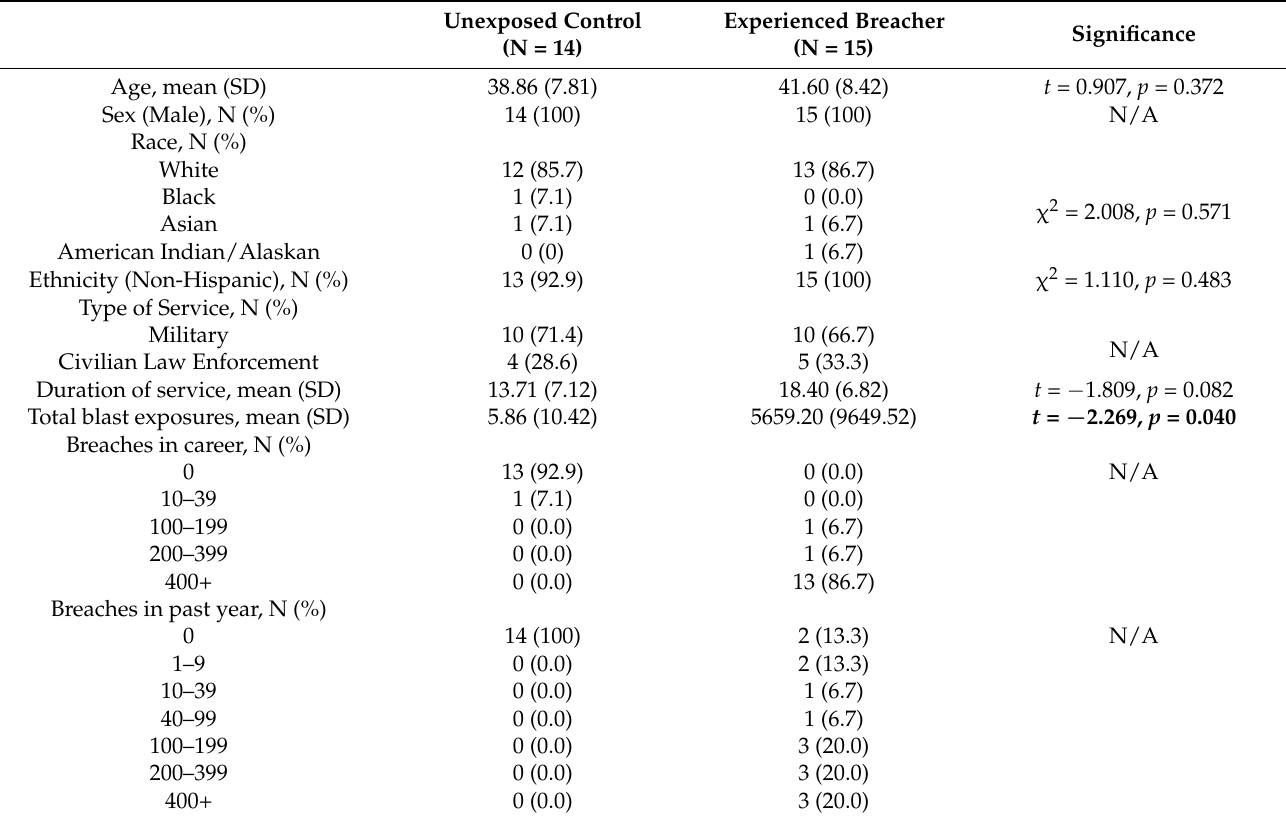
Table 1. Demographic characteristics of study